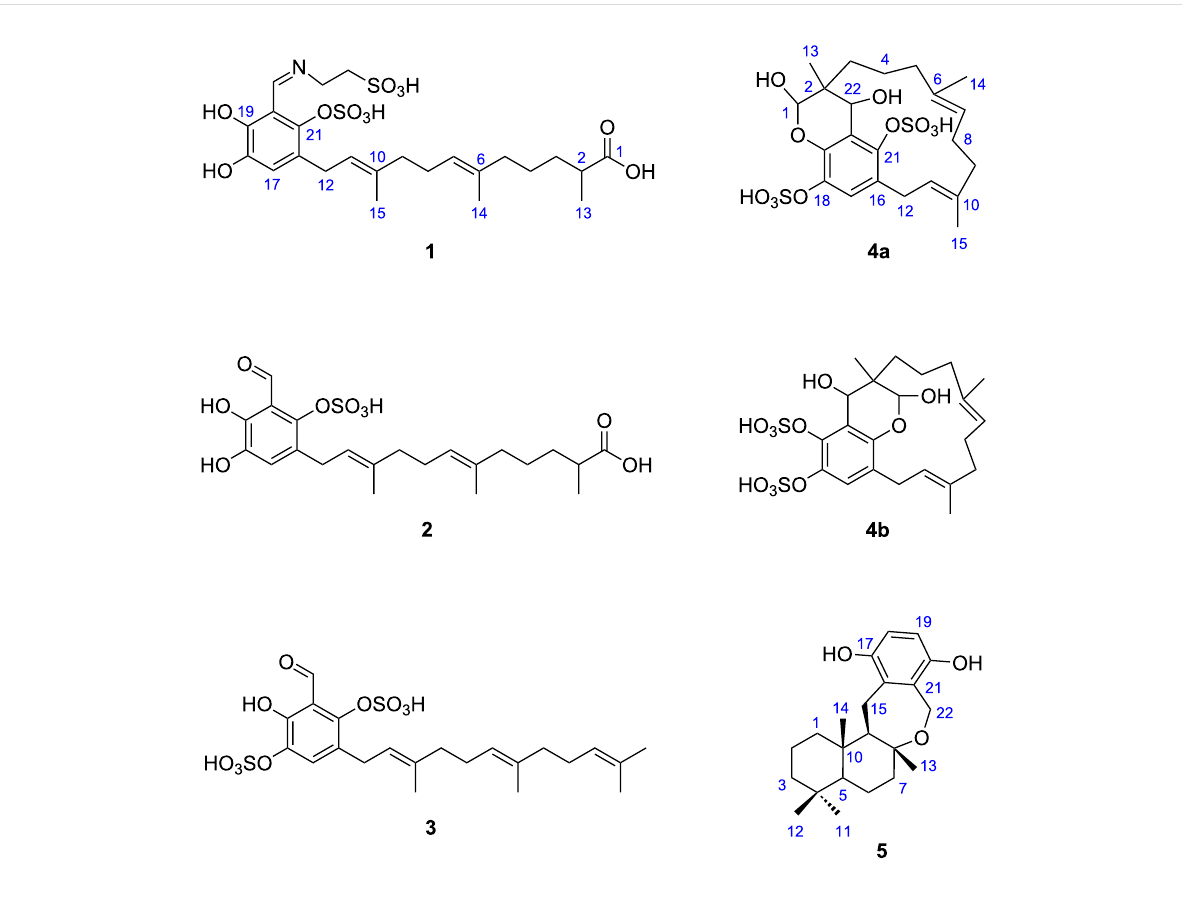
Figure 1: Structures of the new compounds siphonodictyals E1–E4 ( 1 – 4 ) and cyclosiphonodictyol A ( 5 ) isolated from the sponge Aka coralliphagum . Since the structure of siphonodictyal E4 ( 4 ) could not be unambiguously assigned, the two possible constitutional isomers ( 4a and 4b ) are